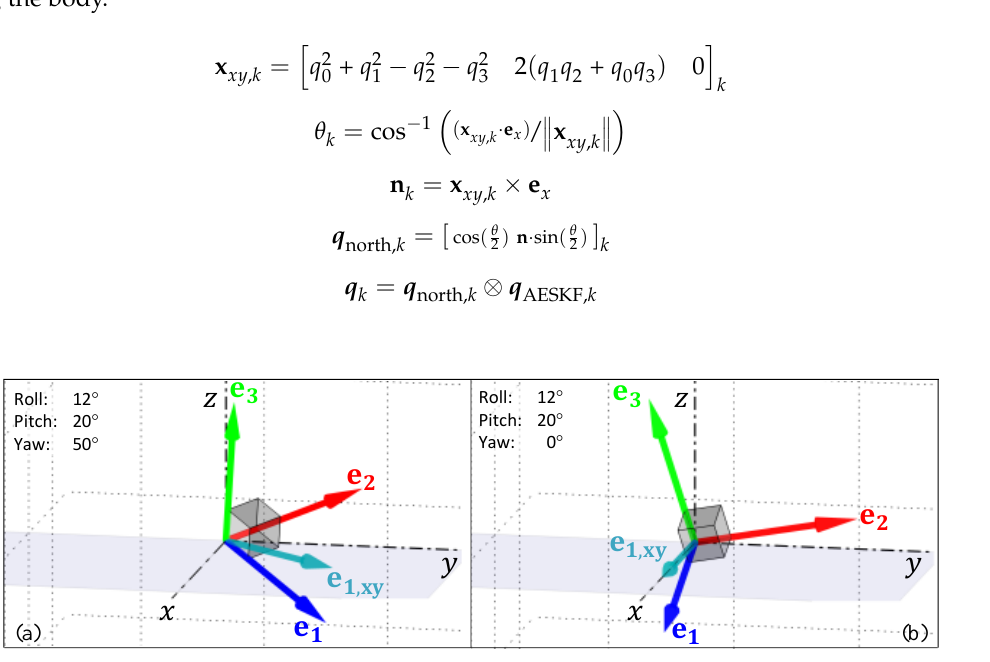
Figure 2. Effect of removing the yaw from an arbitrary orientation (the orthogonal basis defined by the vectors e (in blue), e (in red), e (in green) by aligning it with the x-axis of the standard basis 2 3 1 x , y , z : ( a ) orientation, with an arbitrary yaw angle; ( b ) the same orientation with the yaw component removed (see Equations (2)–(5)). Note: the light blue vector is e , the e basis vector of the orientation 1, xy 1 projected to the xy plane; the pitch and roll angles are